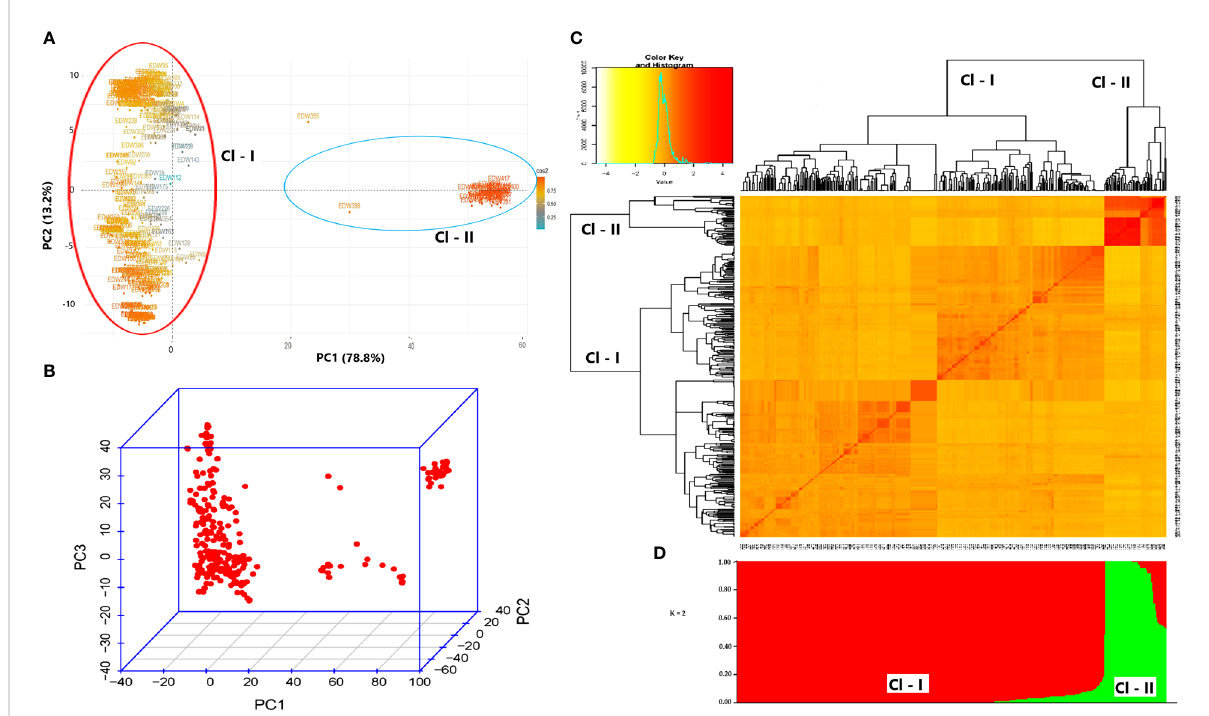
FIGURE 4 Principal component analysis (A, B) , kinship (C) , and population structure analysis (D)